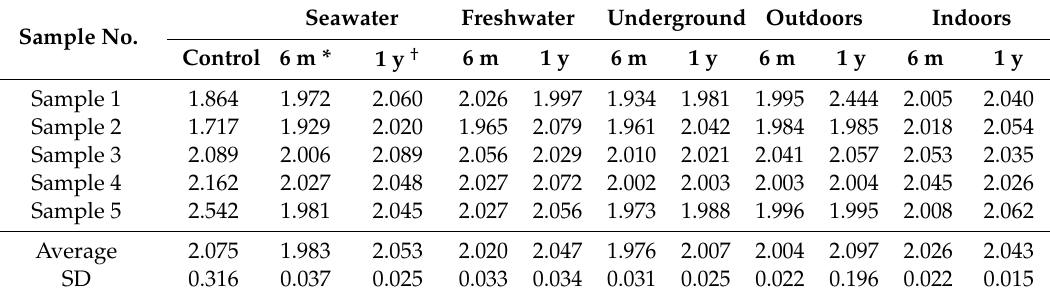
Figure 7. Three-dimensional (3D) images obtained by X-ray microcomputed tomography. The sample was maintained in freshwater for 1 year: ( a ) longitudinal direction; ( b ) minor axis direction. Table 3. Bone density determined by X-ray microcomputed